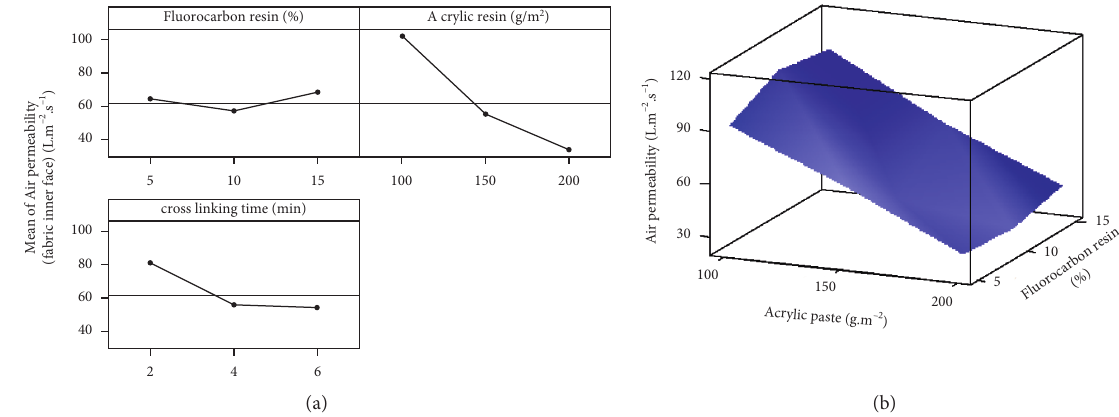
Figure 8: Air permeability behaviors for the coated inner face of woven fabric. (a) Main effect evolutions. (b) Surface plot.